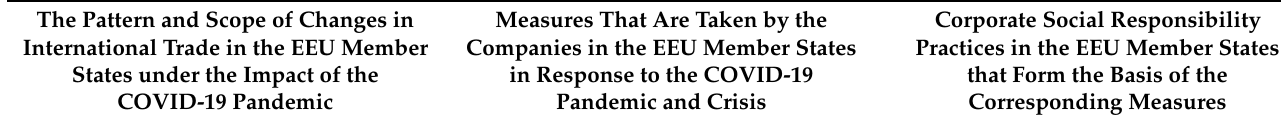
Table 8. Systematization of corporate social responsibility practices in the EEU member states that emerged/intensified in response to the COVID-19 pandemic and